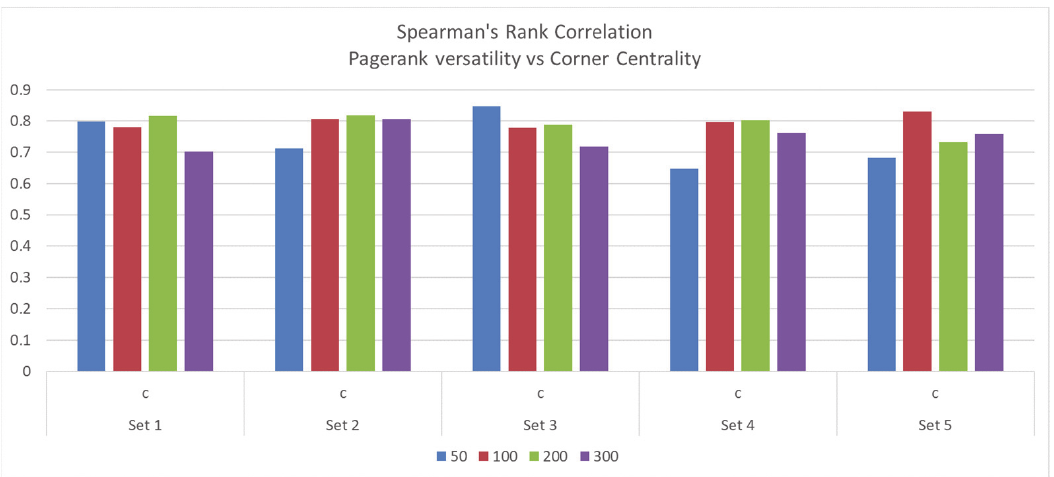
Figure 7. Spearman’s Rank Correlation between the centrality measures: Pagerank versatility and corner centrality. The multilayer networks compared have 50, 100, 200, and 300 nodes. For every set of nodes, we generated five multilayer networks and obtained the correlation and significance values ( 𝑐 and 𝑝 ) for each. Table 7. Spearman’s Rank Correlation between the centrality measures of the Pagerank versatility and corner centrality ( c ) and p ‐ value ( p ).